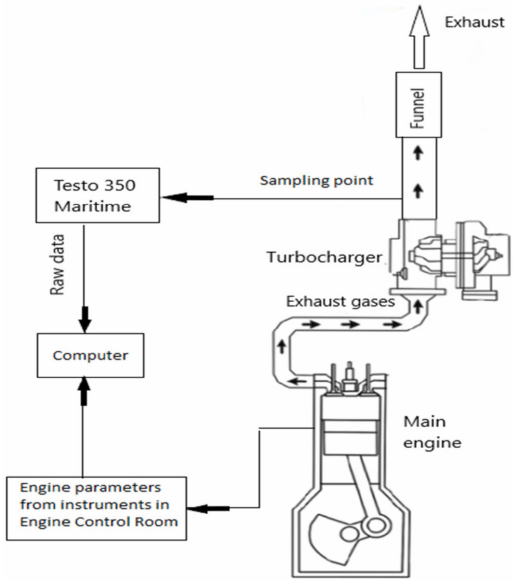
Figure 3. Scheme of measuring equipment